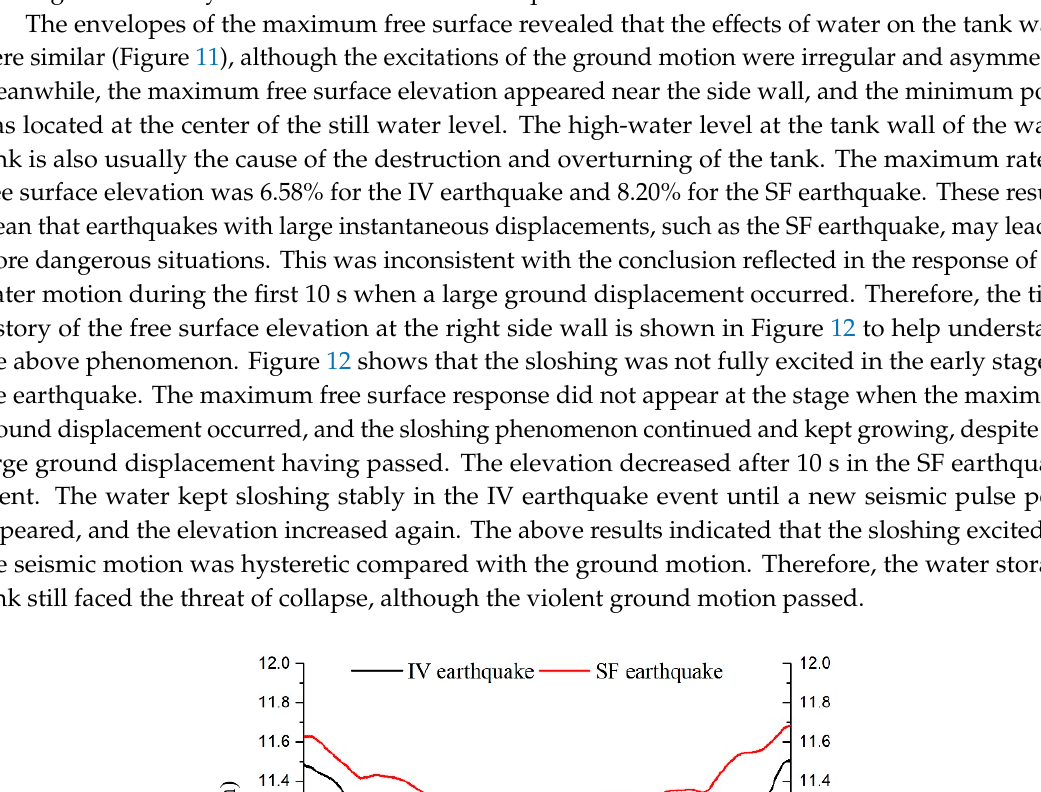
9 of 14 Figure 10. Free surface response at selected moments, ( a ) the free surface response under the Imperial Valley 1940 earthquake, ( b ) the free surface response under the San Fernando 1971